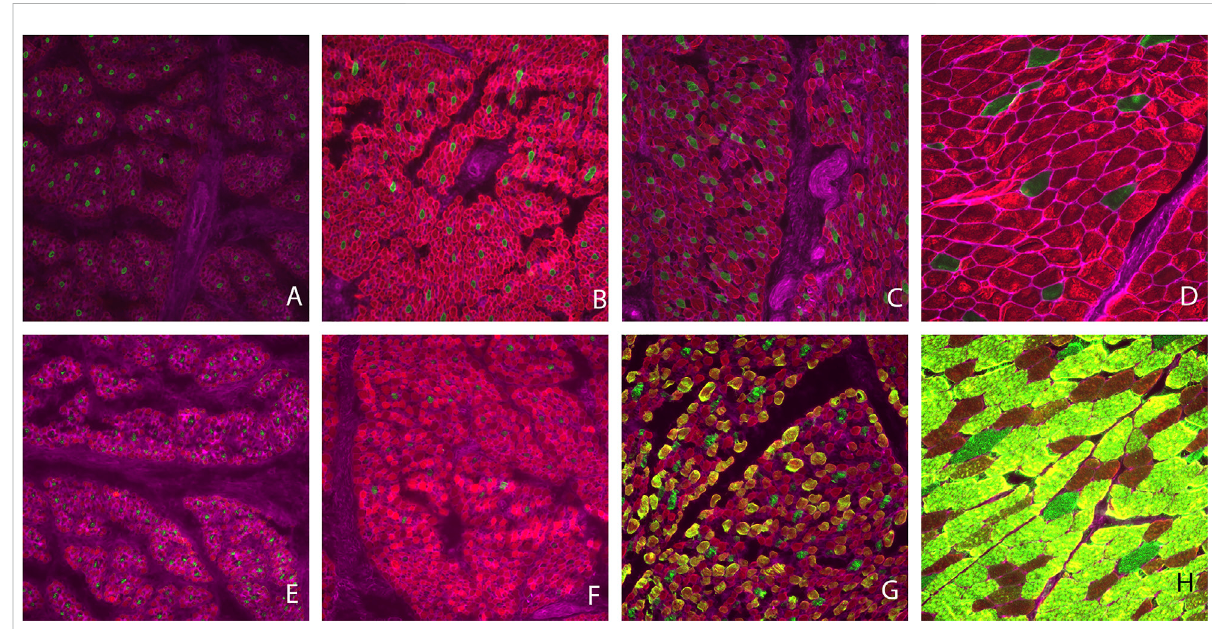
FIGURE 1 Muscle fi ber cross sectional area images. Type I fi bers are stained green and Type II fi bers are red (A – D) . Type IIa fi bers are stained red, Type IIx fi bersarestainedgreenand fi bersexpressingTypeIIaandIIxproteins(TypeIIax)areyellowincolor (E – H) .Gestationald85samples (A,E) ,gestational d 110 (B,F) , gestational d 133 (C,G) , maturity d 243 postnatal (D,H)